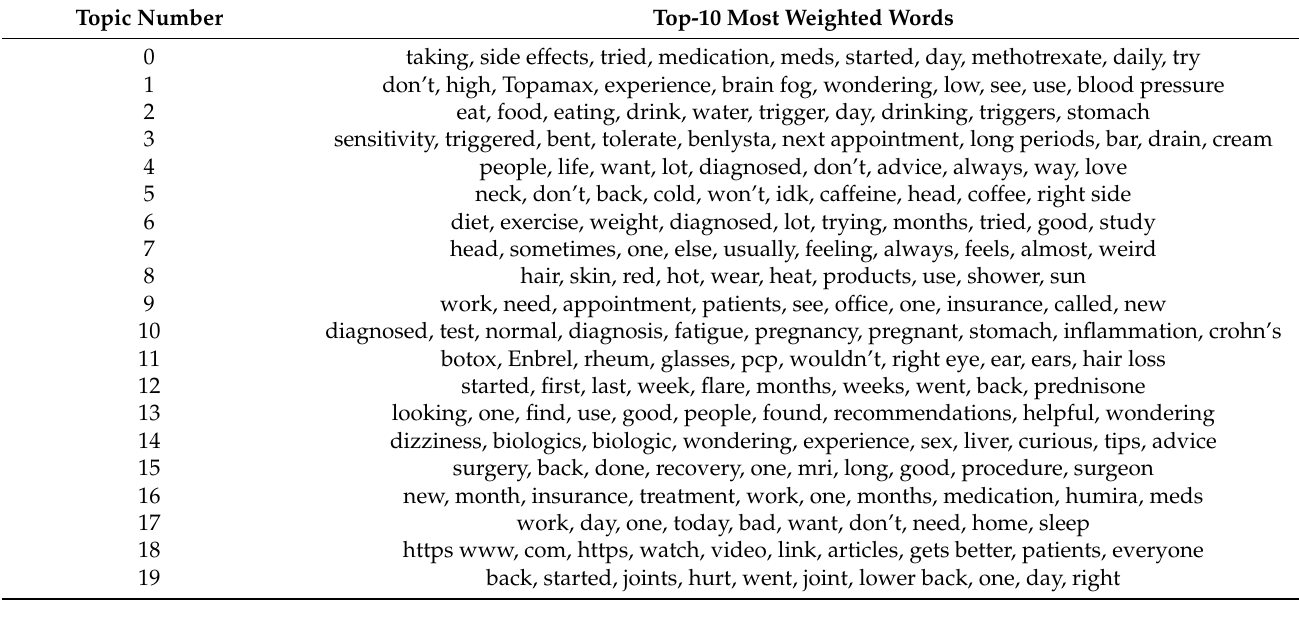
Table A4. Top 10 most weighted words of the 20 extracted topics from the Reddit Reports of Chronic Pain (RRCP) dataset.